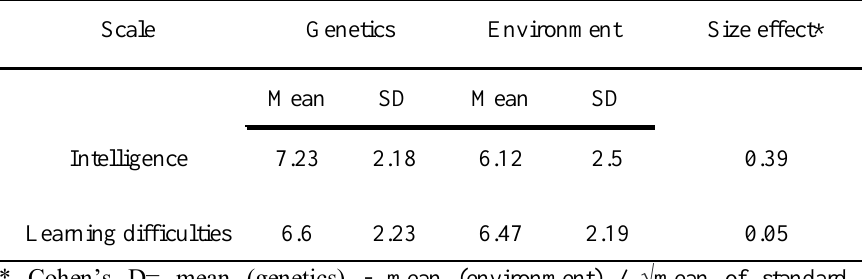
Mean, standard deviation and size effect of numerical scales from 0 to 10 on the weight of genetic and environmental influence on intelligence and learning